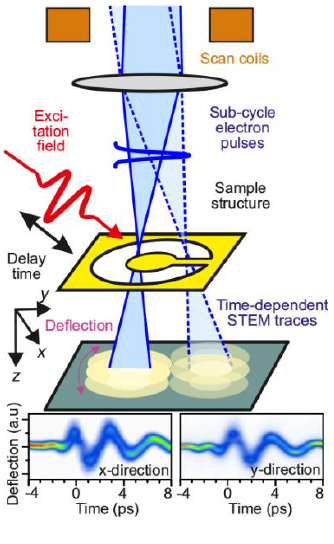
Fig. 2 . Scetch setup of sub- cycle scanning transmission electron microscopy. Preliminary results are shown in lower